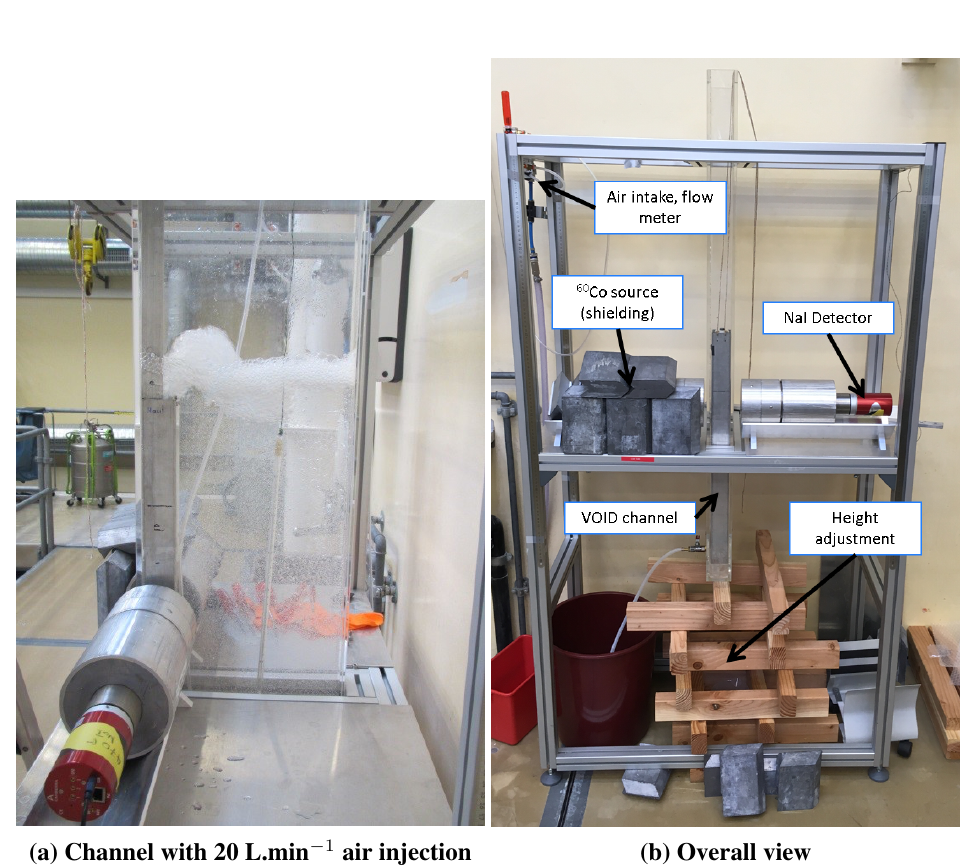
Figure 1: Attenuation measurement experimental